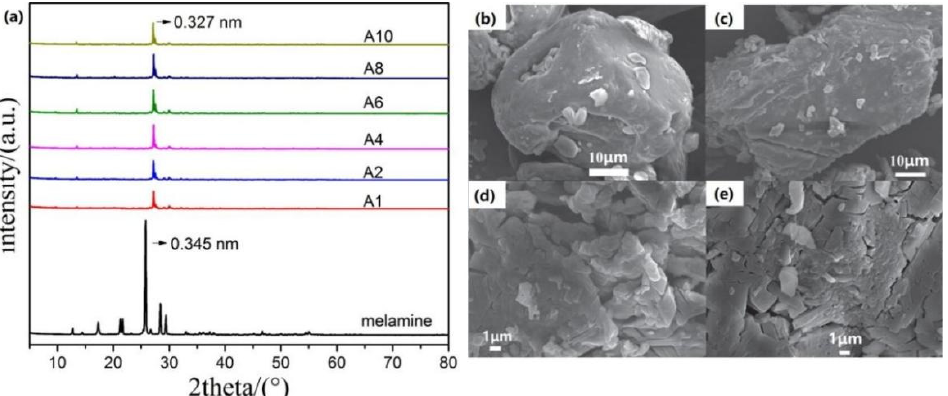
Figure 3. ( a ) XRD patterns of melamine and acid-treated melamine samples; SEM images of g-C 3 N 4 prepared with ( b ) melamine and acid-treated melamine for ( c ) 2 h, ( d ) 6 h and ( e ) 8 h. Used with